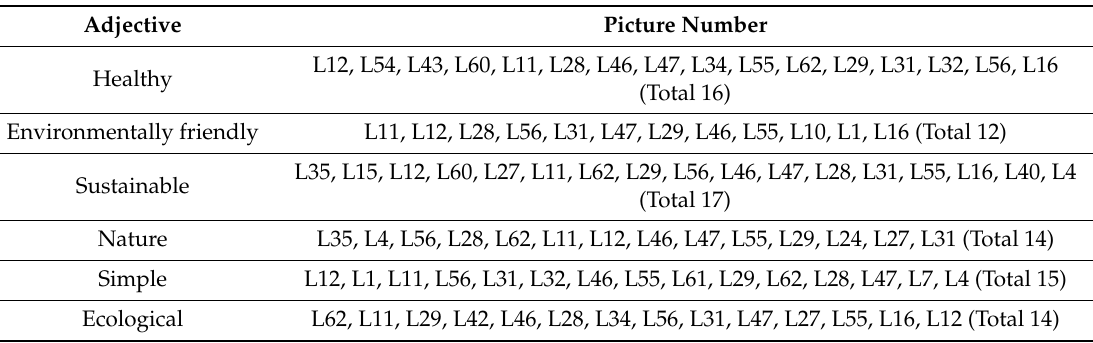
Table 4. Pictures with the grey relational coe ffi cient of image adjectives >